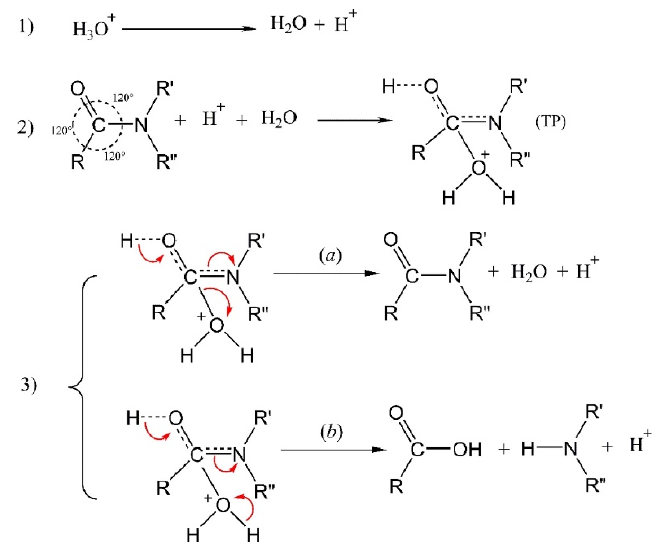
Figure 1. Acidification mechanism of the polyamide separation layer [73].